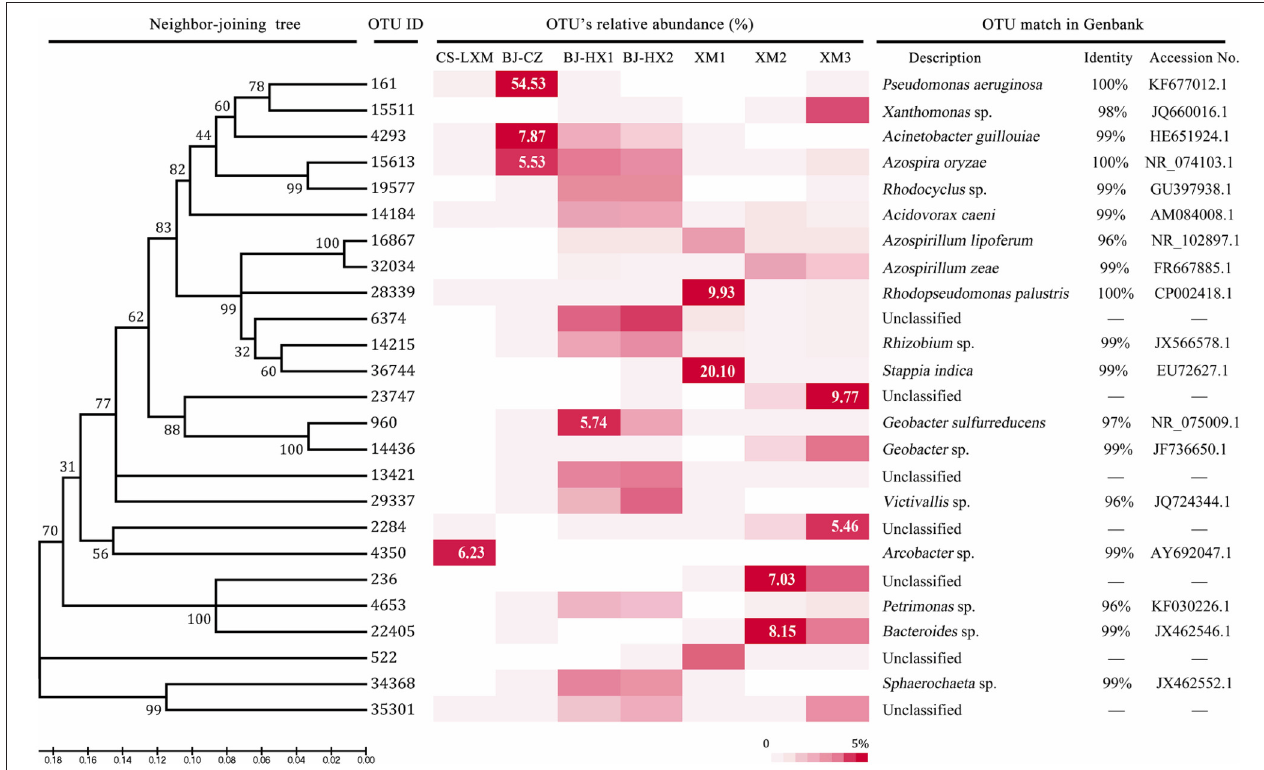
FIGURE 4 | Relative abundance of the core OTUs (3% distance) in the sequenced 16S rRNA gene sequences.